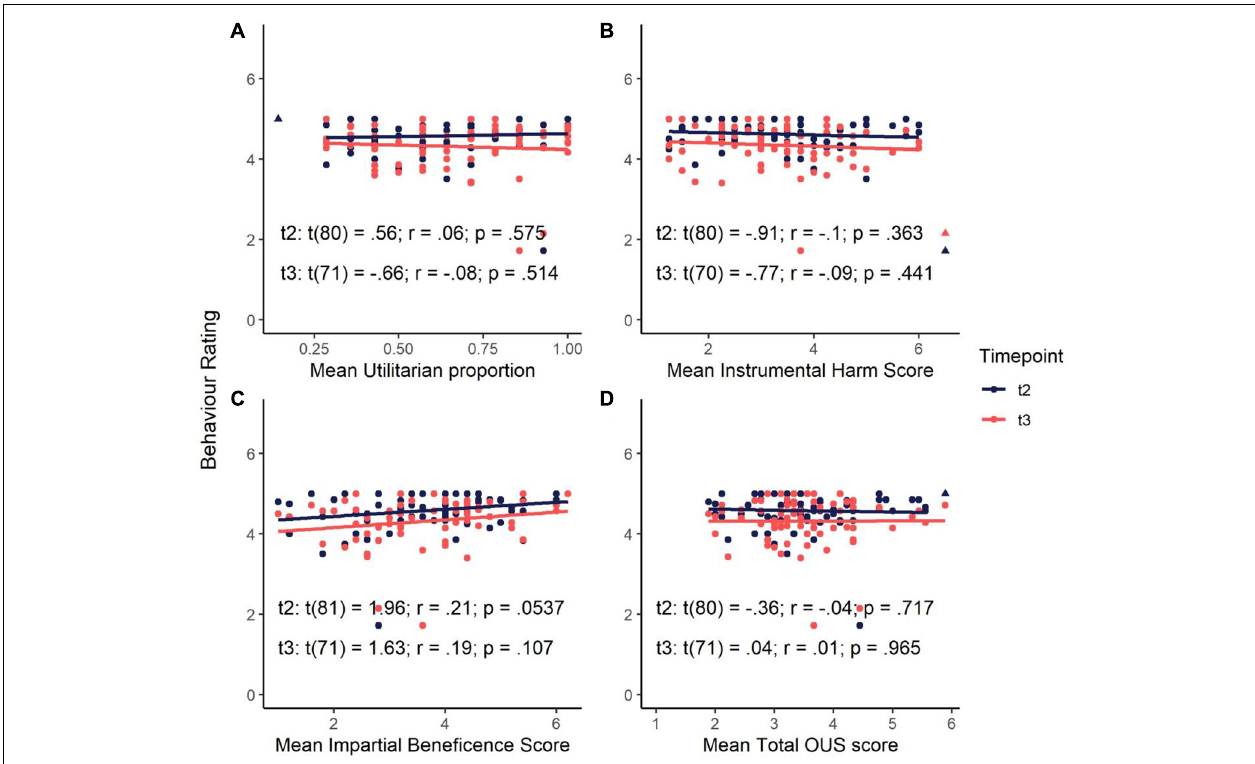
FIGURE 3 | Association between engagement in COVID-19-related behaviours at timepoints 2 and 3 and baseline (A) utilitarian proportion in sacrificial moral dilemmas, (B) mean Instrumental Harm score, (C) mean Impartial Beneficence score and, (D) mean total Oxford Utilitarianism Scale (OUS) score. Outliers removed from the regression analyses are marked with